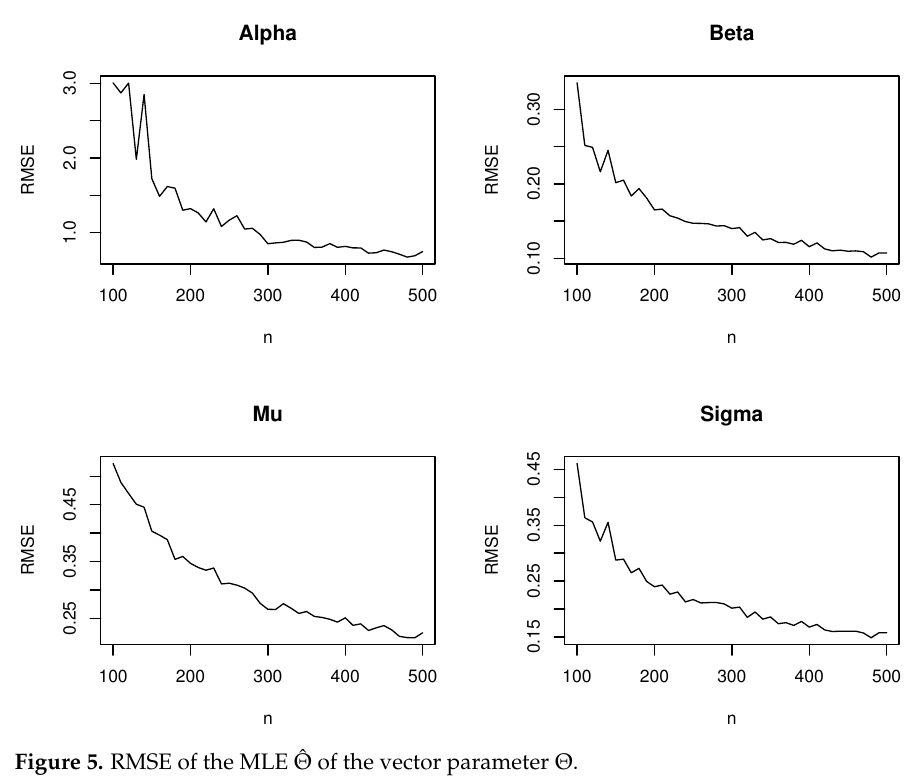
Figure 5. RMSE of the MLE ˆ Θ of the vector parameter Θ .